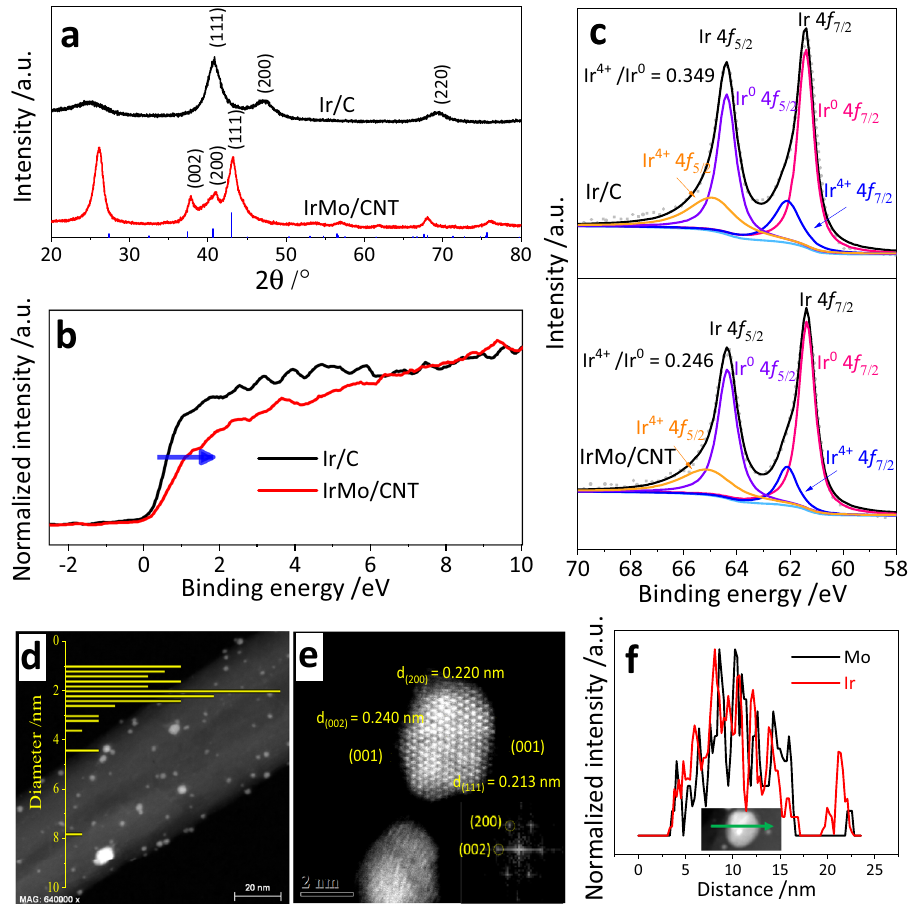
Fig.2|Physicalcharacterization.a XRDpatterns.Theblueverticallineshowsthe PDF of IrMo 25 . b Valance band spectra. c Ir 4 f XPS spectra. d HAADF/STEM image. The inserted bar graph shows the NPs size distribution for IrMo. e Atomic-